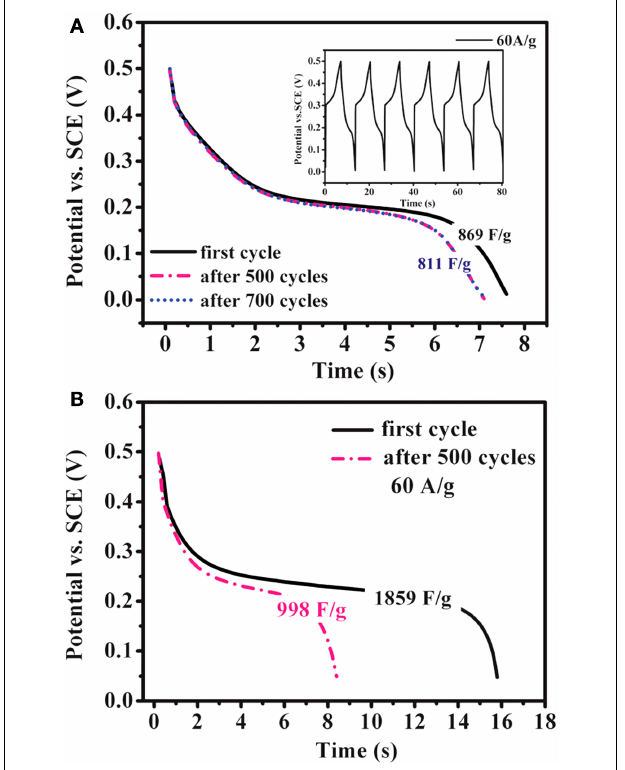
FIGURE 2 | Discharge curves of (A) the Ni foam/graphite nanosheets/Ni(OH) 2 electrode at the current density of 60Ag (cid:0) 1 for 700 cycles and (B) the Ni foam/Ni(OH) 2 electrode at the same current density for 500 cycles . The inset in (A) shows the charge–discharge curves of the composite electrode. The curves were obtained from Wang et al.